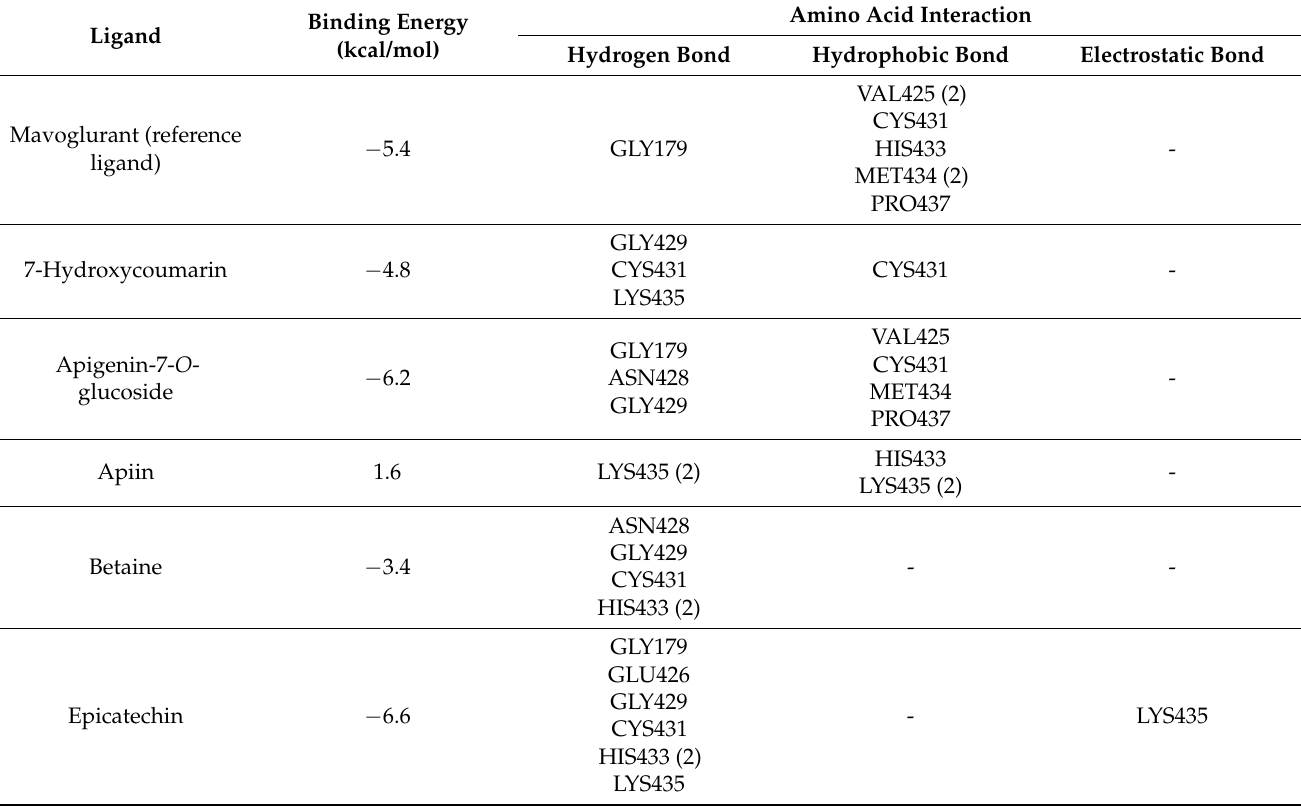
Table 4. Molecular docking results of candidate ligands at the catalytic domain of E3 ubiquitin-protein ligase parkin (PDB ID: